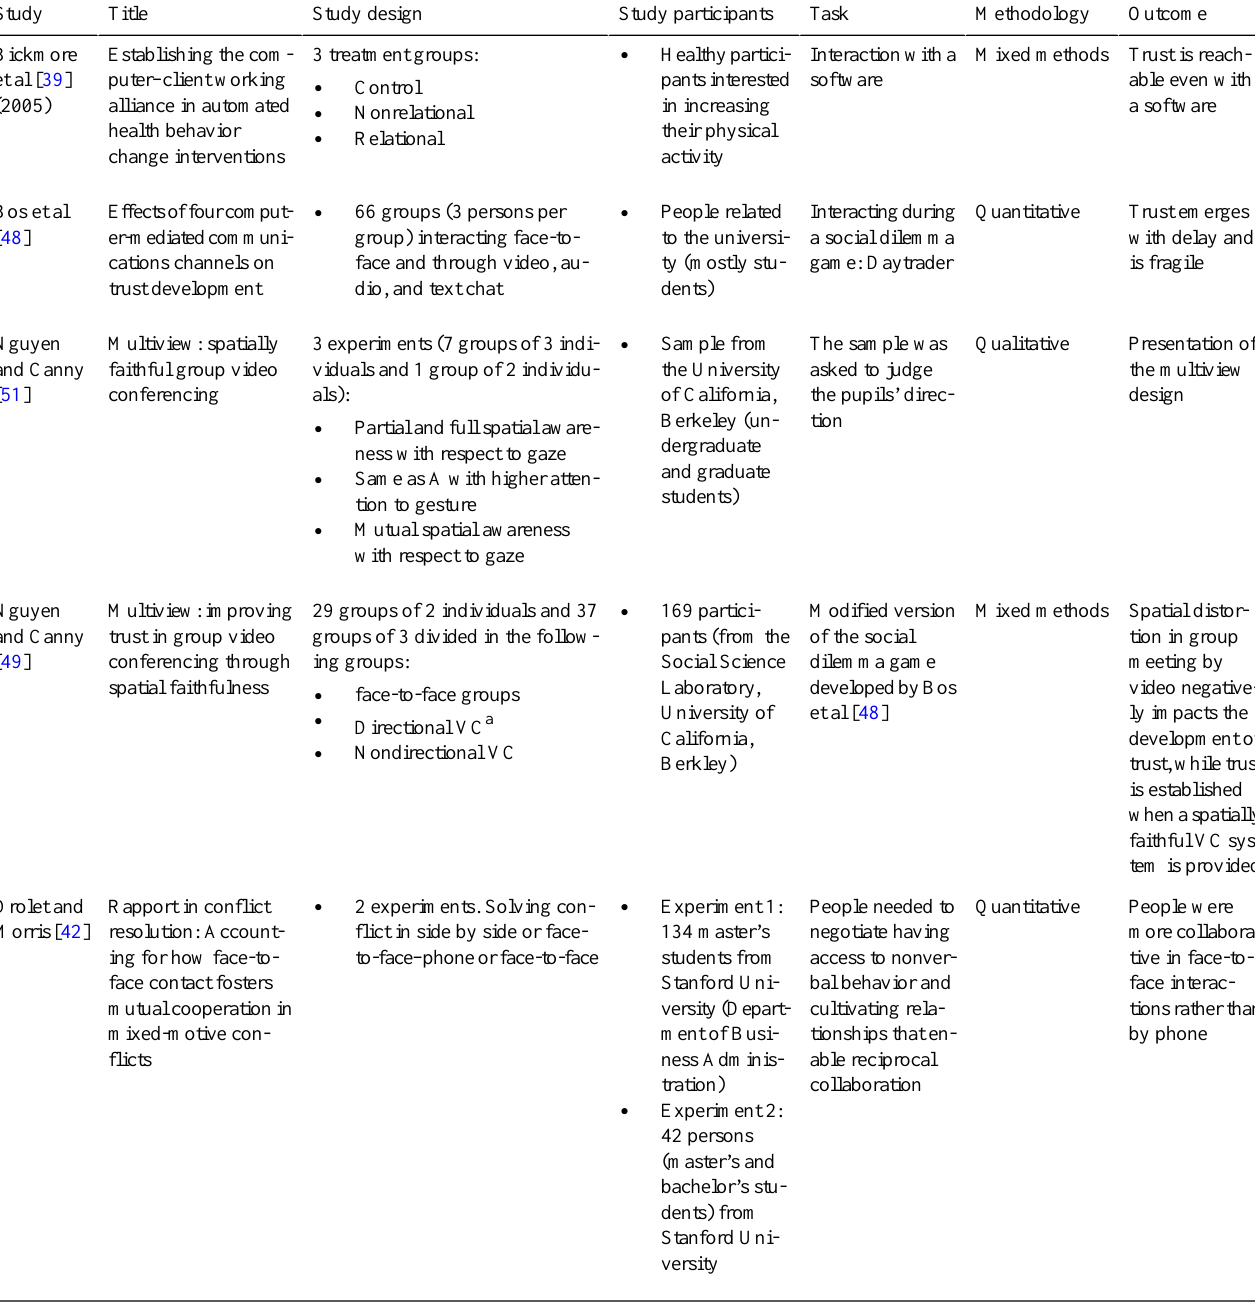
Table 1. Trust in computer-mediated communication.